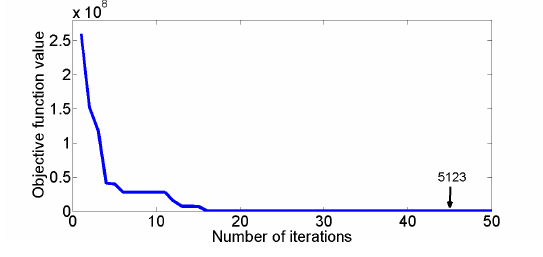
Figure 13. Objective-function convergence.